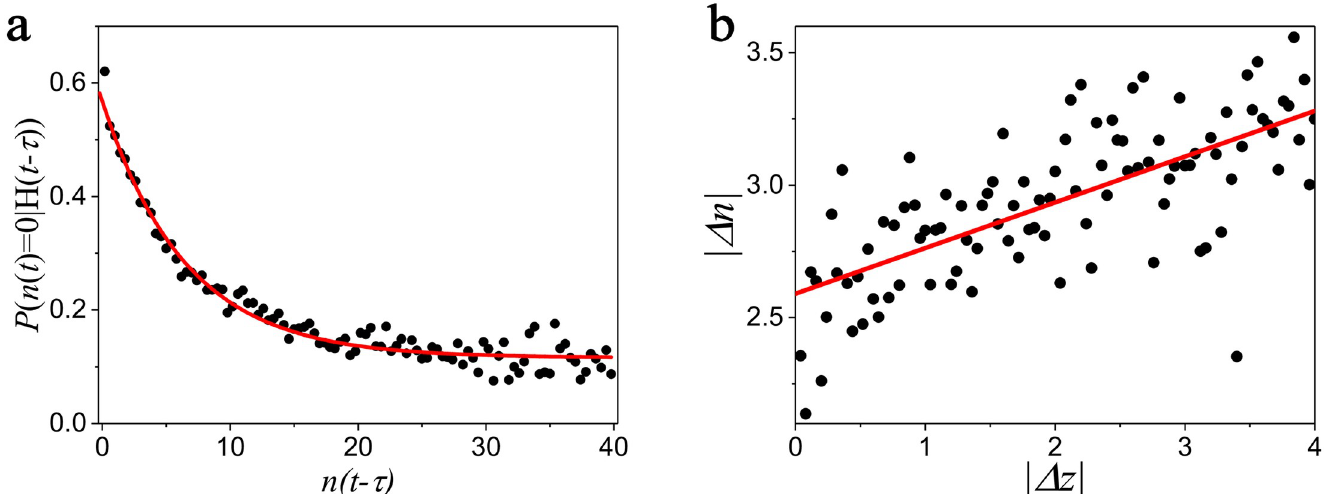
Fig 5. a . The relationship between the conditional probability P ( n ( t )= 0| H ( t − τ )) and the order volume n ( t − τ ). The red line is the fitting line. b . The relationship between the absolute value of the change of order volume | Δ n | versus the fluctuation | Δ z |.